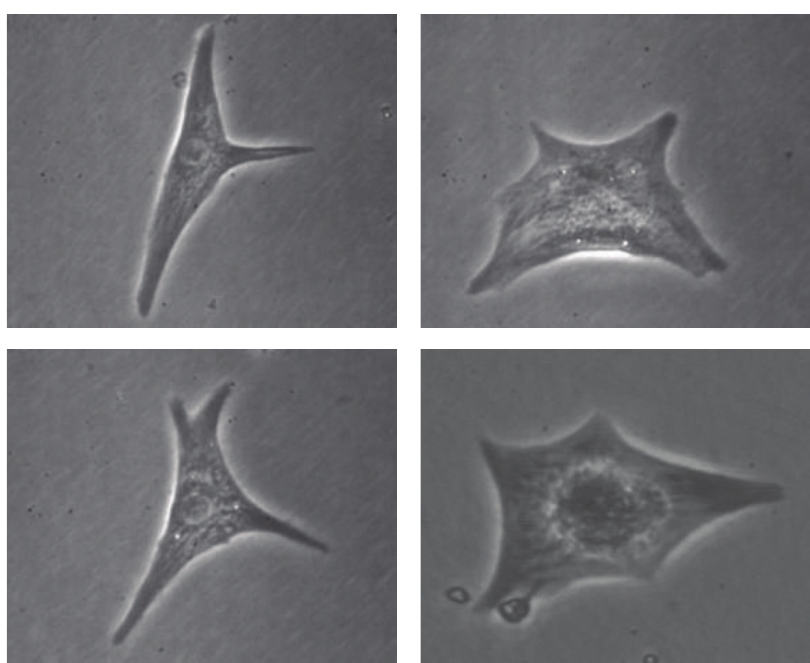
Figure 1: Four di ff erent neonatal cells after developing pseudopodia and spreading out on the substrate. They show almost unique shapes which greatly complicate the analysis of